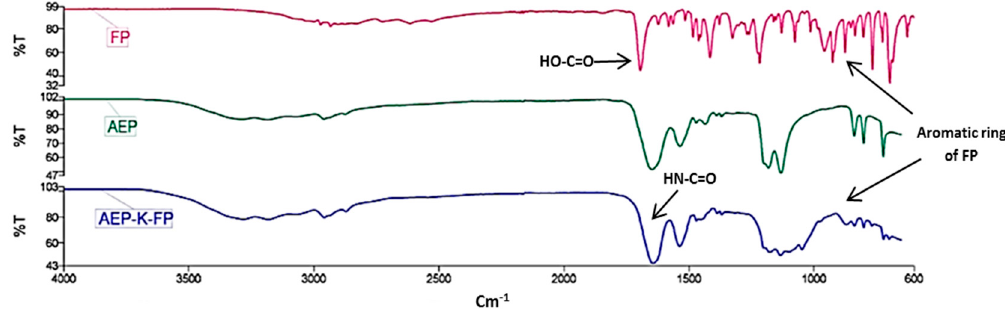
Figure 3. FTIR spectra of drug (FP) alone, peptide (AEP), and AEP-K-FP. The spectra show shifting peaks due to the formation of peptide linkages at 3200 and 1646 cm -1 . The FP spectrum shows a strong carbonyl band at 1700 cm − 1 , which represents its COOH functional group that disappears in the AEP-K-FP spectrum due to amide linkage formation. In addition to the appearance of a new peak at 782 cm − 1 , it corresponds to the aromatic ring of FP with its C = C peak at 910 cm − 1 in the AEP-K-FP spectrum, which confirms the FP attachment to the